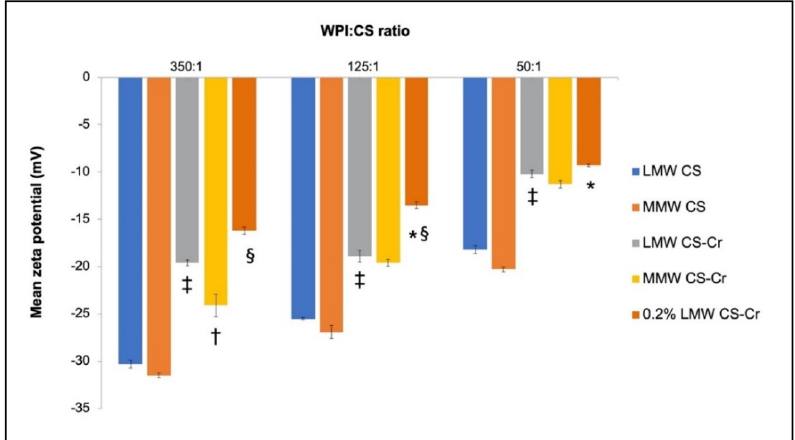
Figure 7. Zeta potential of chromium-entrapped WPI nanoparticles when using di ff erent MWs and concentrations of chitosan at various WPI:CS ratios. Results are shown as mean ± SD (n = 3). Data were considered statistically di ff erent when p < 0.05. * indicates a significant di ff erence between 350:1 0.2% chromium-entrapped particles and 0.2% particles at other ratios, † indicates a significant di ff erence between LMW CS-Cr and MMW CS-Cr at the same ratio, ‡ indicates a significant di ff erence between LMW CS and LMW CS-Cr at the same ratio, § indicates a significant di ff erence between LMW CS-Cr and 0.2% LMW CS-Cr at the same